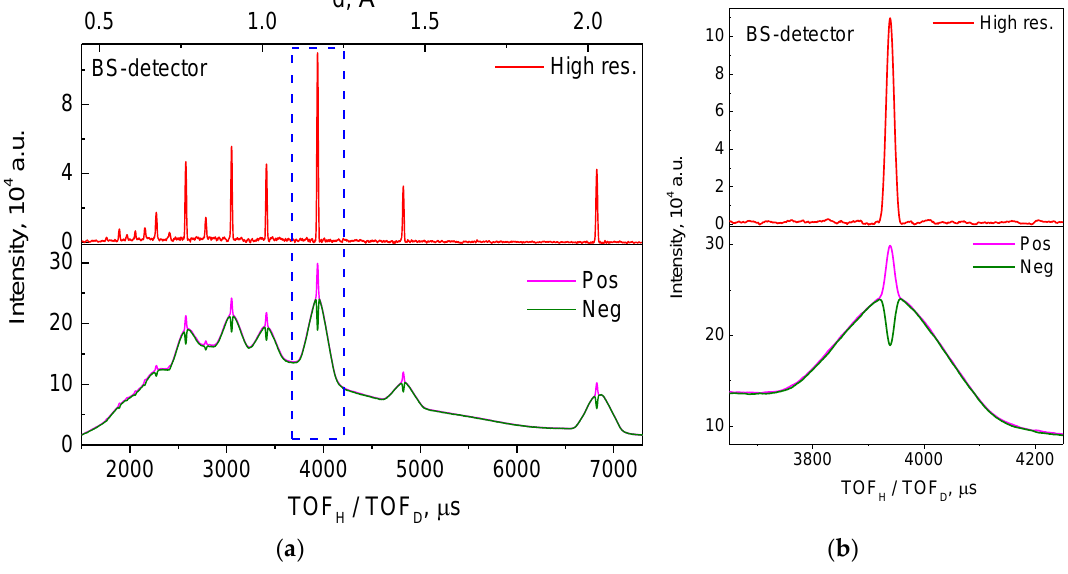
Figure 9. ( a ) RTOF neutron diffraction spectra measured from a standard α -Fe powder sample with the maximal Fourier chopper speed Ω max = 4000 rpm. At the bottom, “positive” I + ( t ) and “negative” I – ( t ) correlation spectra are shown. The upper pattern is the high-resolution diffraction RTOF spectrum calculated as a difference of “positive” and “negative” patterns: H(t) = I + ( t ) − I – ( t ); ( b ) Diffraction peak (211) region in the same RTOF spectra.